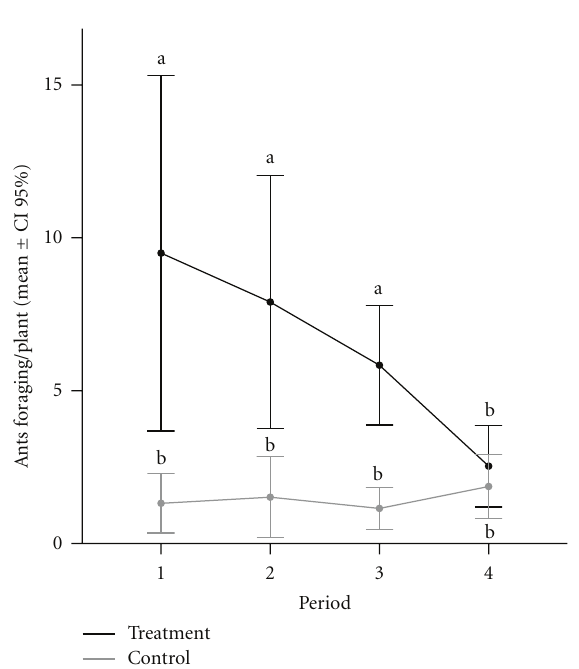
Figure 1: Positive relationship between the availability of hemipter- ans colonies and the amount of ants foraging on each plant (Repeated measures ANOVA: Group ∗ Period: F (3;354) = 4.4; P < 0 . 01). The largest amount of ants was recorded in period 1 and gradually decreases until period 4 when it became identical to values found in all phases of the control group. Di ff erent letters indicate significant di ff erences according to post hoc test (LSD: P < 0 .